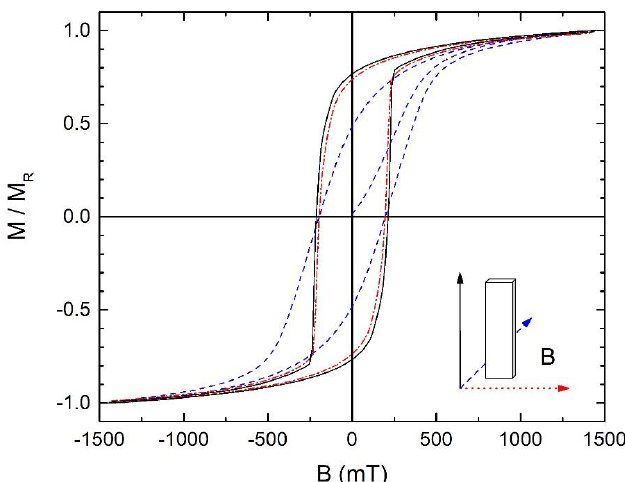
Figure 5. Hysteresis loops measured at room temperature along the longitudinal, transversal and perpendicular relative directions of magnetic field with the ribbon.